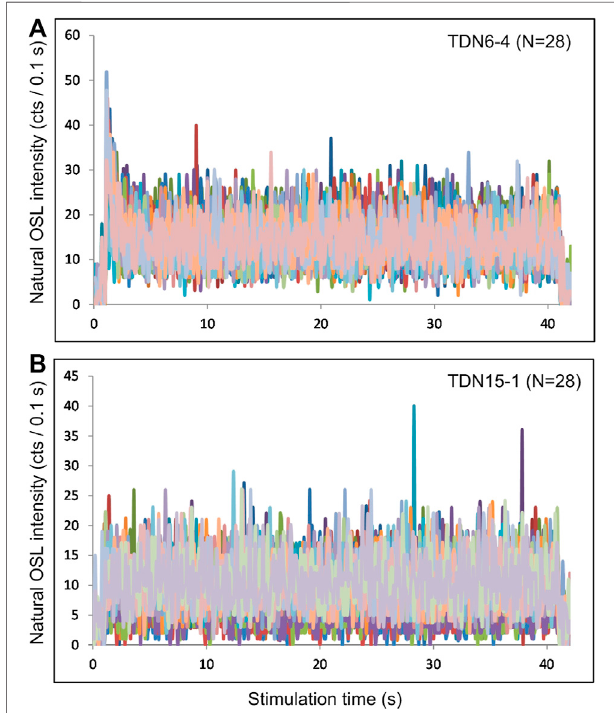
FIGURE 2 | Natural post-IR OSL decay curves of samples TDN6-4 and TDN15-1.